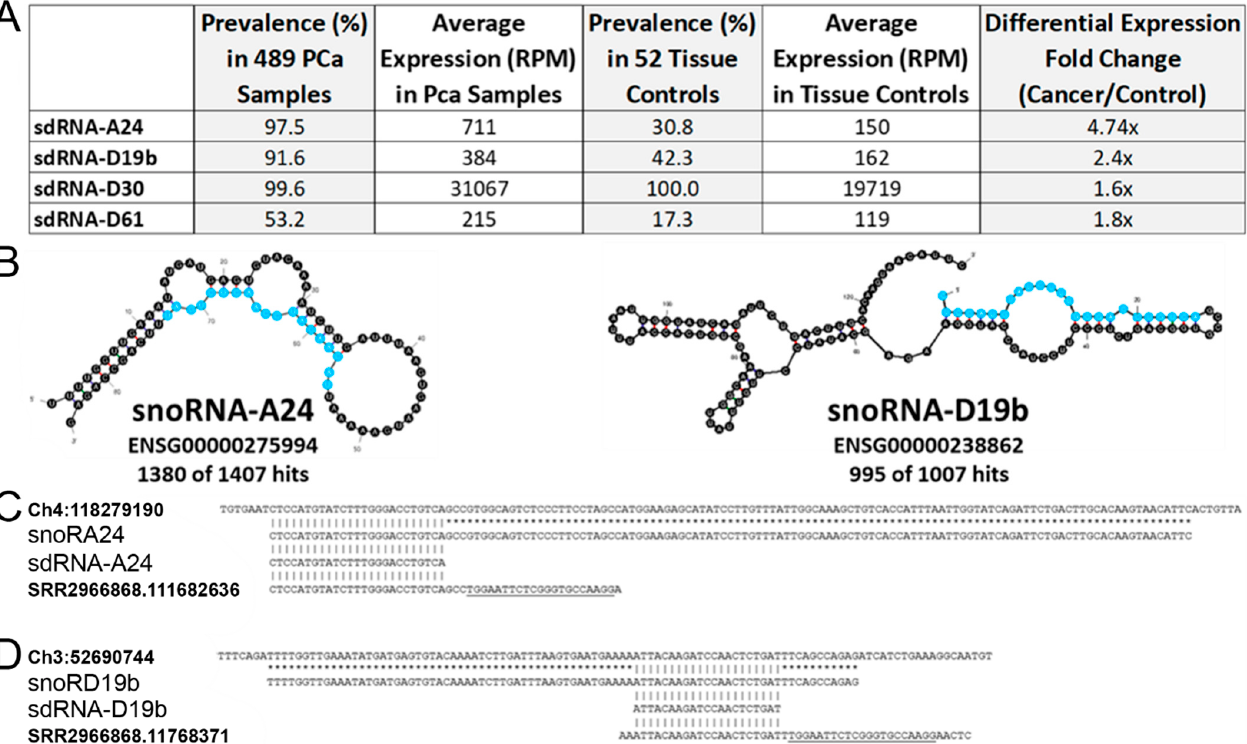
Figure 2. SdRNAs-D19b and -A24. ( A ) SdRNA-A24 and sdRNA-D19b are